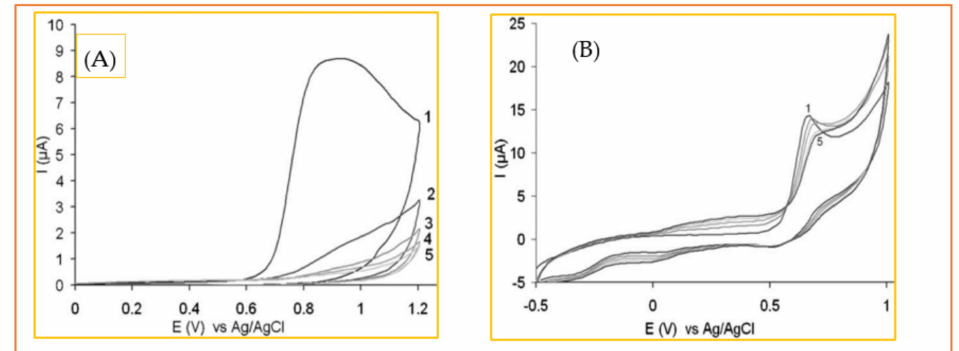
Figure 11. Cyclic voltammograms of 1 mM solution of tryptophan in 0.1 M PBS (pH 7) for five consecutive scans at ( A ) bare GCE and a ( B ) gold nanoparticle/ionic liquid electrode. Reprinted with permission from ref. [218]. Copyright 2010